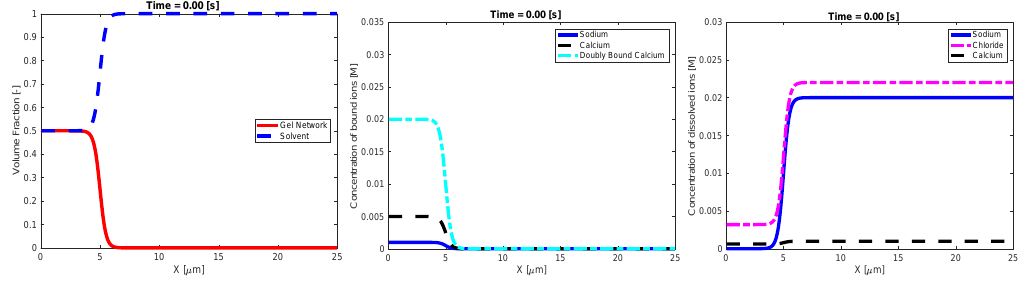
Figure 1. Example initial profiles of: volume fraction ( left ); bound ionic concentrations ( middle ); and dissolved ionic concentrations ( right